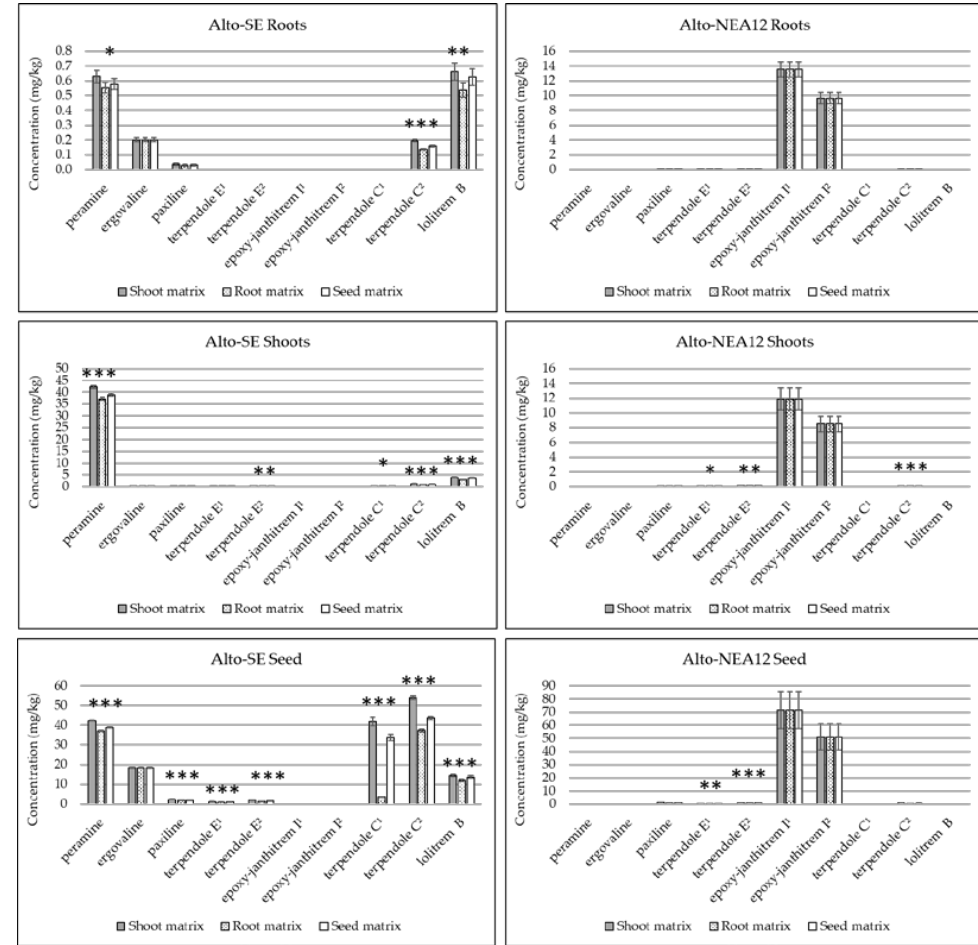
Figure 2. Comparison of alkaloid concentrations (mg/kg) in different perennial ryegrass tissues (pooled, n = 5) quantitated using either the same or different in-matrix standards (root, shoots or seeds). Error bars represent standard errors of the means (SEMs). Asterisks denote significance for each alkaloid according to single-factor ANOVA (* p <0.05; ** p <0.01; *** p <0.001). Denotation of alkaloids as ‘ 1 ’ indicates molecular ion in the MS1 spectrum; denotation of alkaloids as ‘ 2 ’ indicates fragment ion in the MS1 spectrum.